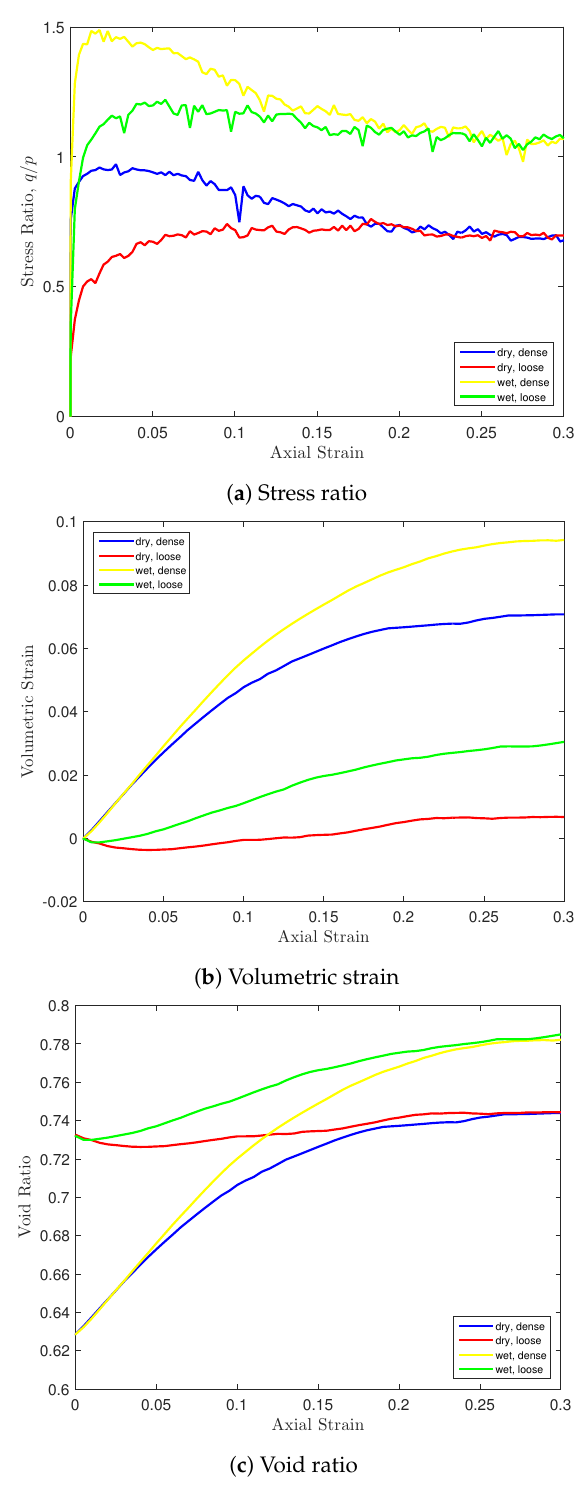
Figure 9. Stress-strain behaviors of dry and wet